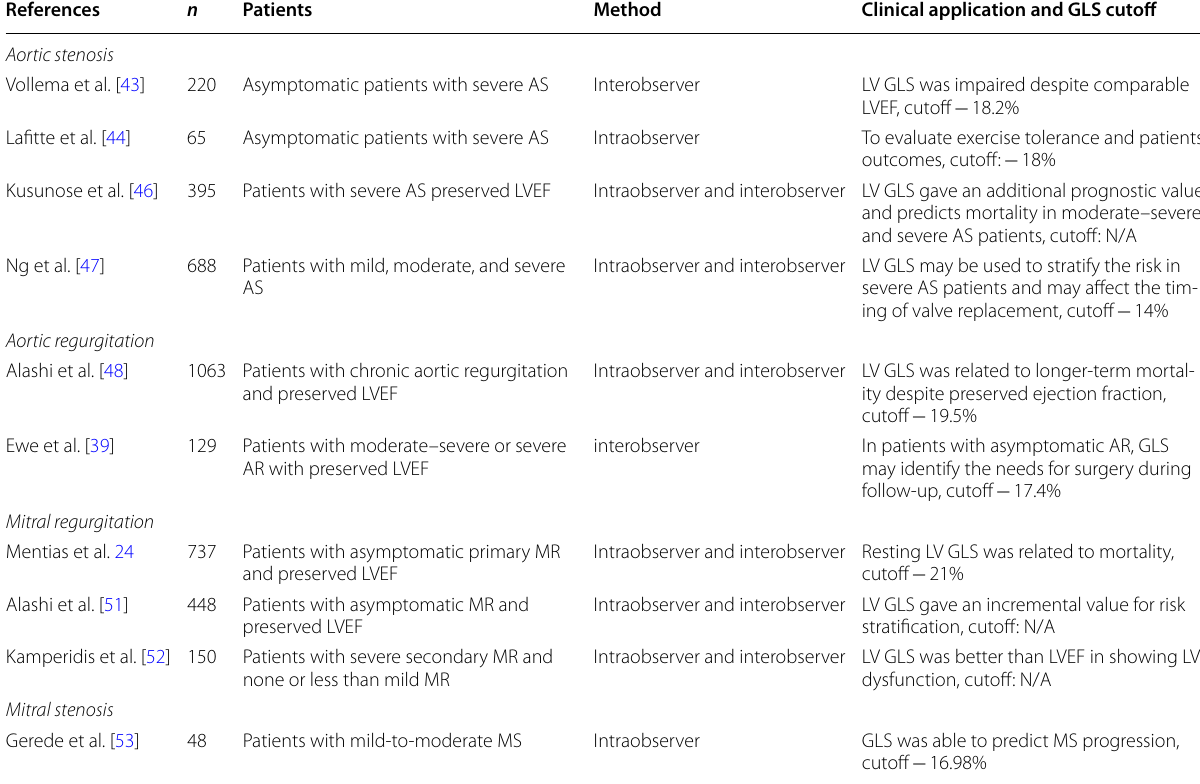
AR, aortic regurgitation; AS, aortic stenosis; LVEF, left ventricular ejection fraction; LV GLS, left ventricle global longitudinal strain; MR, mitral regurgitation; MS, mitral